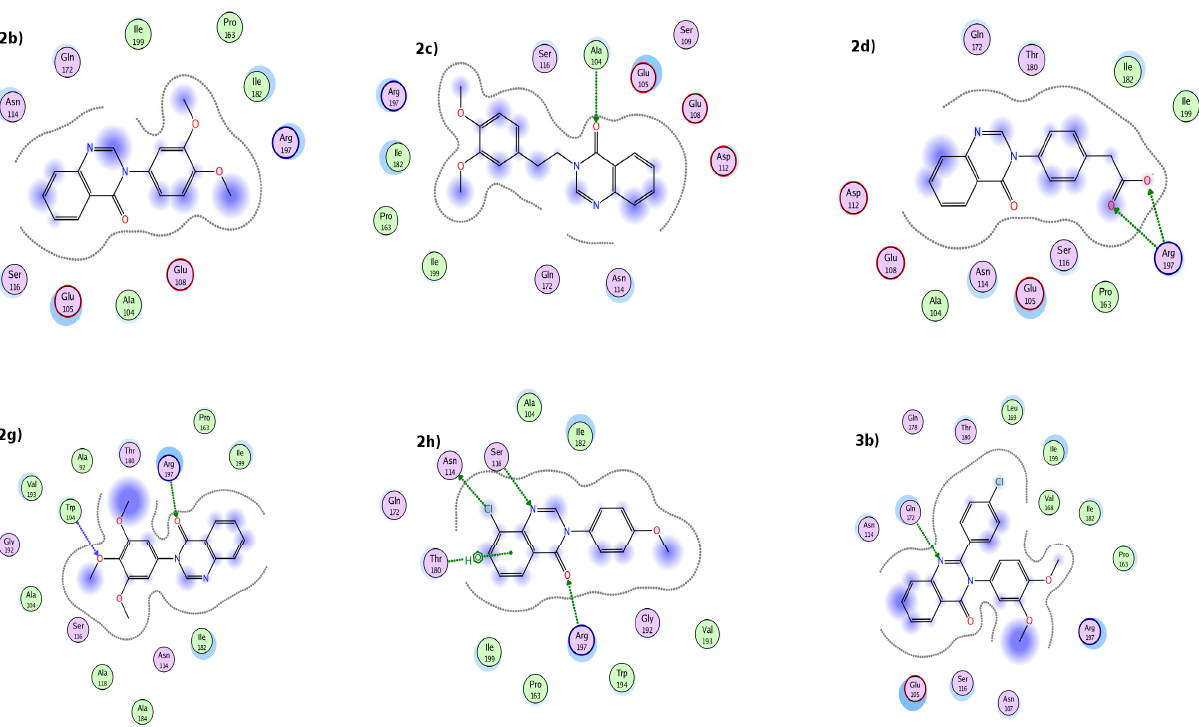
Figure 2. Molecular Docking Interaction diagram for the most potent compound 3a . Panel ( a ) is a two-dimensional representation of the docked pose by Poseview. Panel ( b ) representing three-dimensional view by